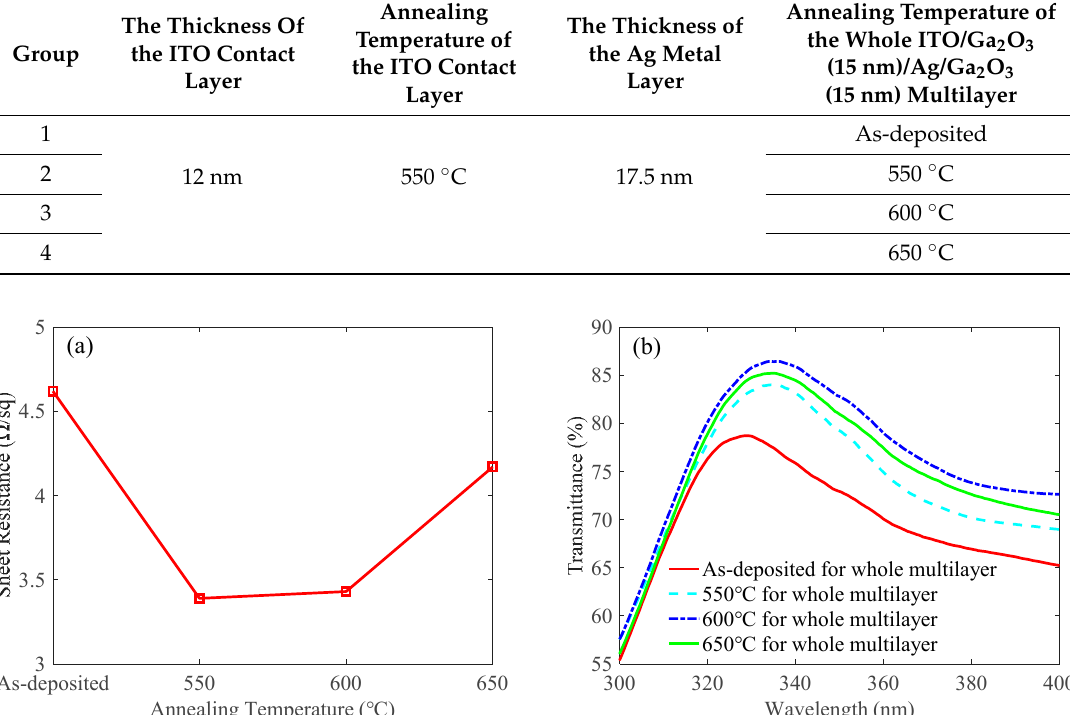
Figure 5. Effects of the annealing temperature of the whole ITO/Ga 2 O 3 /Ag/Ga 2 O 3 multilayer on ( a ) sheet resistance and ( b ) transmittance when the thickness of the ITO contact layer was 12 nm, the annealing temperature of the ITO contact layer was 550 °C, and the thickness of the Ag metal layer was 17.5 nm.